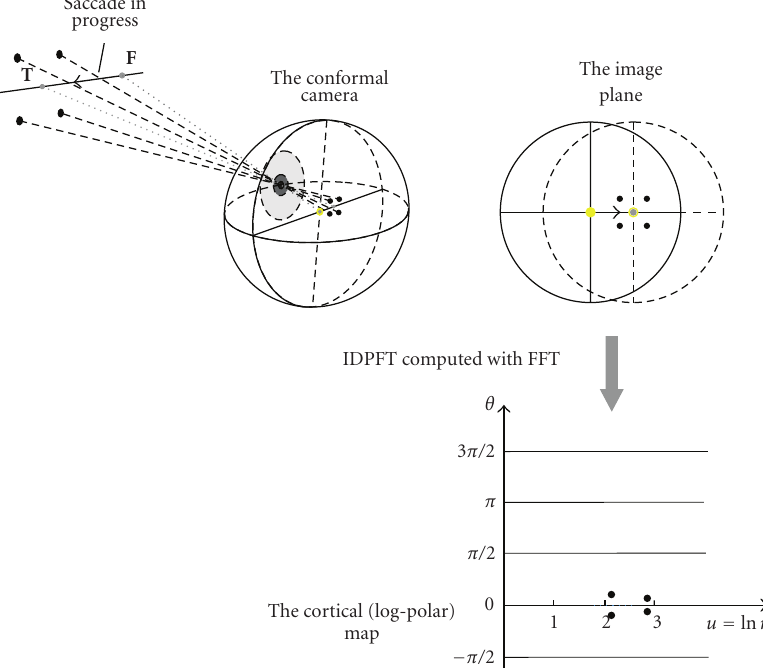
Figure 6: The local retinotopic mapping of four probes flashed around the saccade target at T